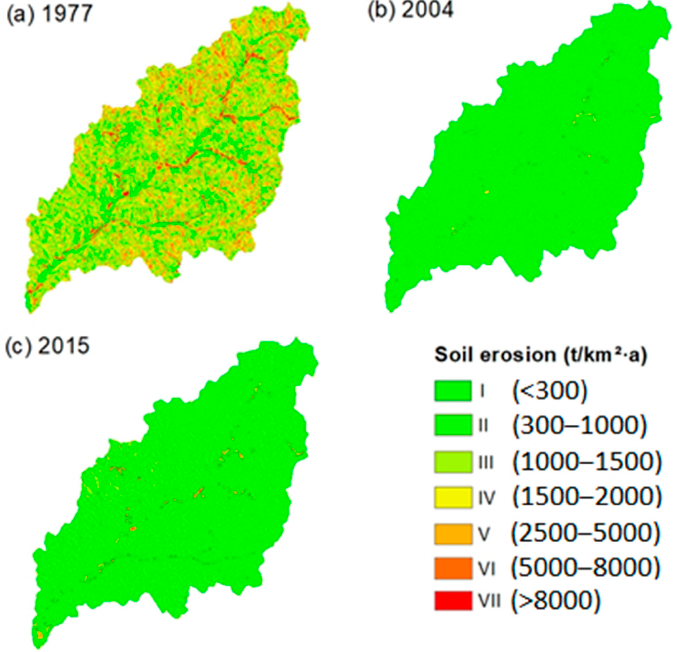
Figure 2. Soil erosion distribution in the JYG watershed in ( a ) 1977, ( b ) 2004 and ( c ) 2015. Table 4. Distribution of grades divided by soil erosion intensity from 1977 to 2015 in the JYG watershed.